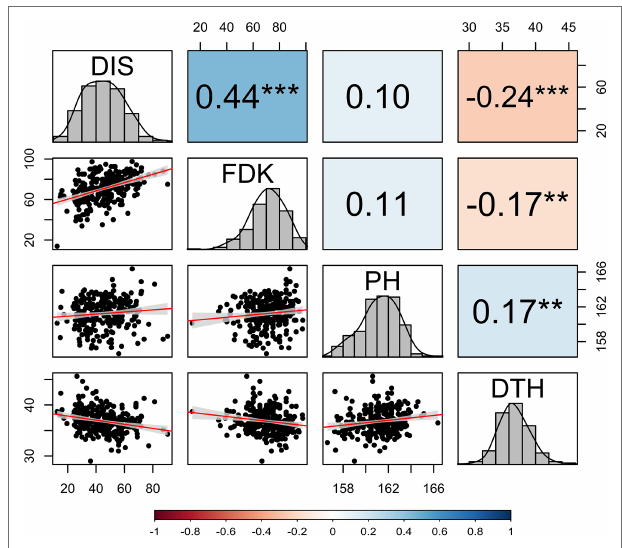
FIGURE 1 | Correlation coefficients among investigated FHB traits, PH, and DTH calculated by using the best linear unbiased estimates (BLUEs) obtained from a combined analysis of hard winter wheat panel of 257 breeding lines over two years. DIS, FHB disease index; FDK, Fusarium- damaged kernel percentage; PH, plant height; and DTH, days to heading. The diagonal of the pair plot elucidates the frequency distribution for four traits and lower triangle shows the bivariate scatterplots with fitted lines. Statistically significant differences are denoted by an asterisk (*), where ** p ≤ 0.01 and *** p ≤